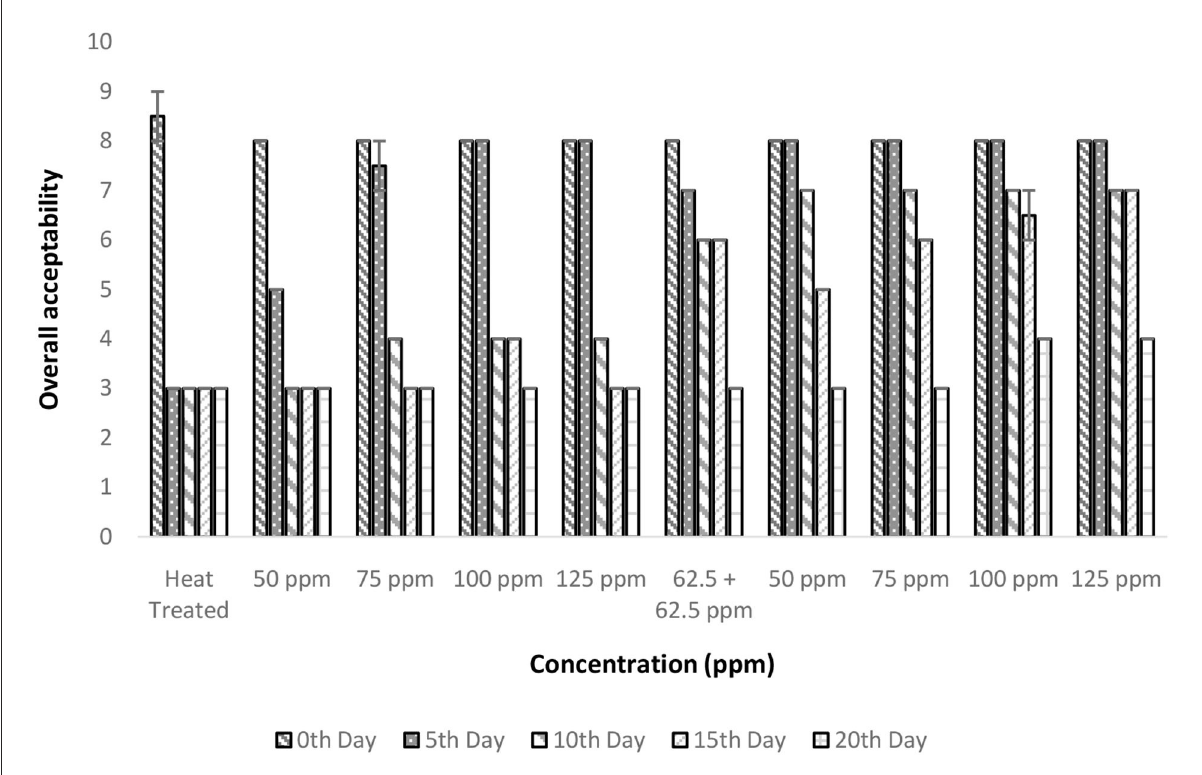
FIGURE8 Overall acceptability vs. concentration plot of bio-preservatives during the storage